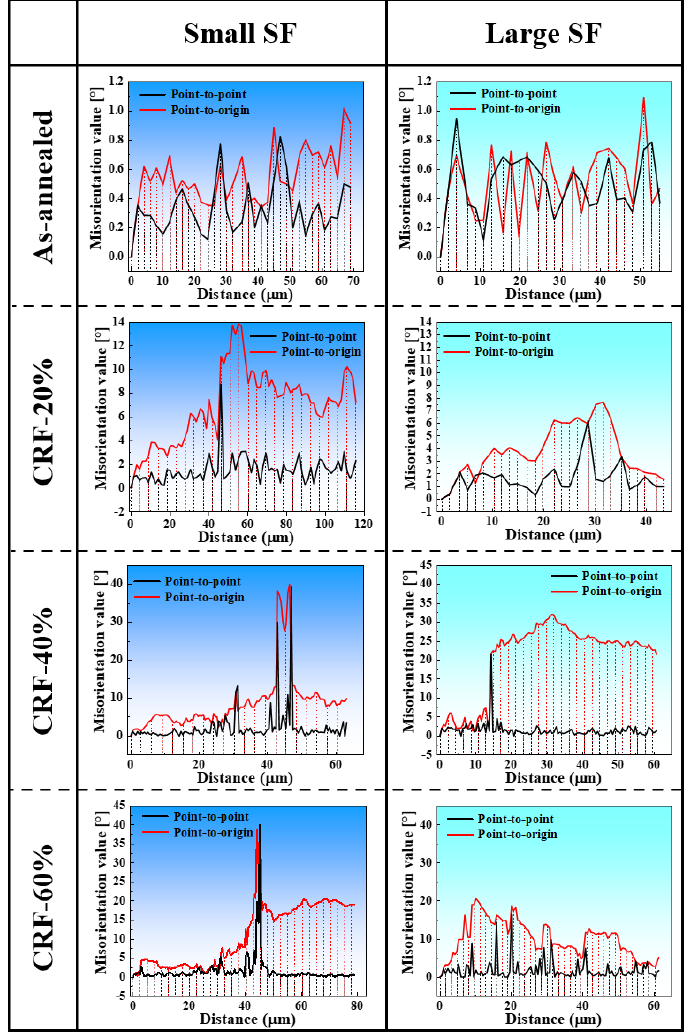
Figure 12. The misorientation values within large SF and small SF grains.